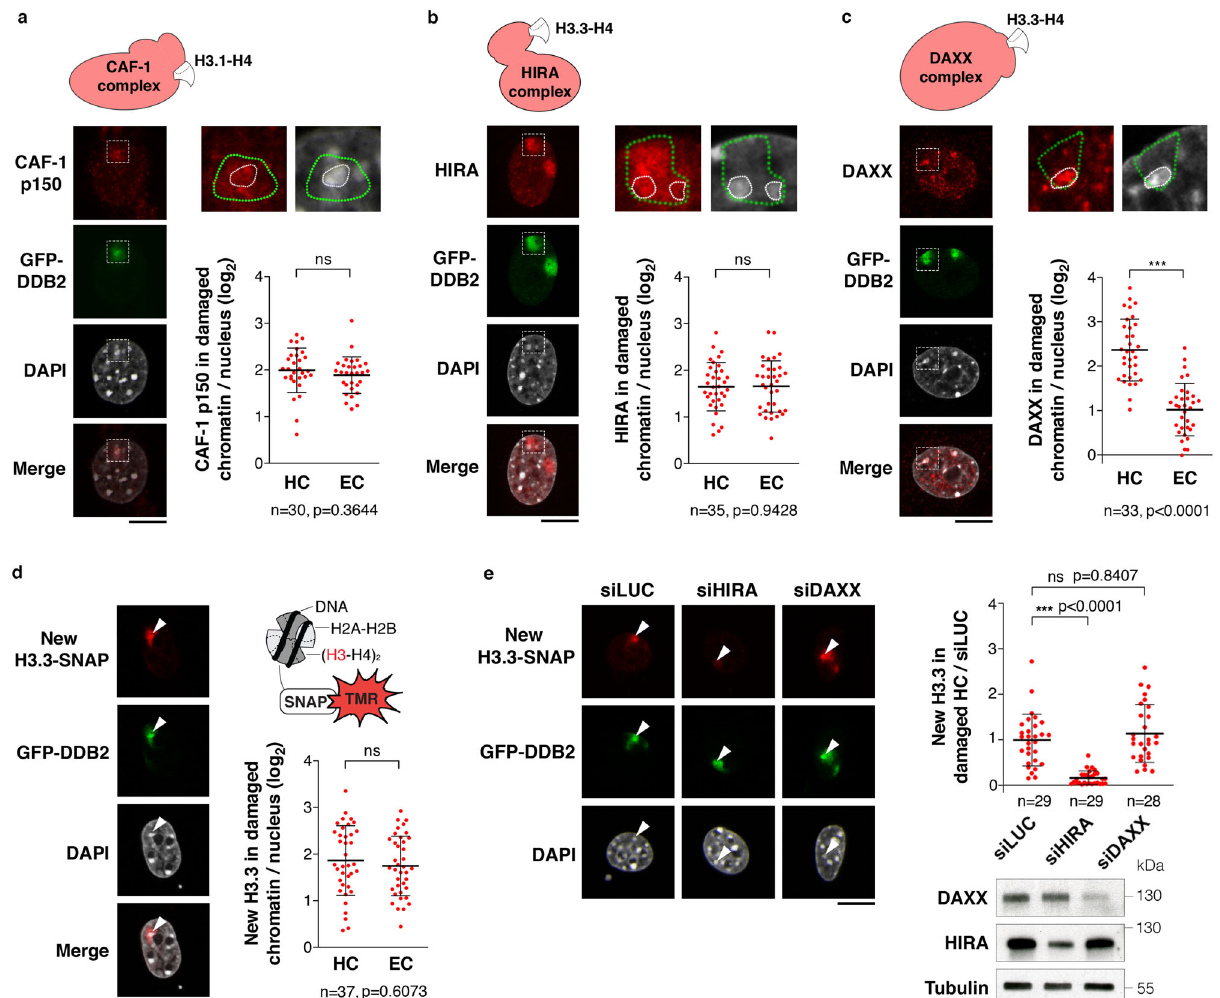
Fig. 5 Histone H3 deposition in UVC-damaged heterochromatin. Recruitment of the H3.1 histone chaperone CAF-1 (p150 subunit) ( a ), and of the H3.3 histone chaperones HIRA ( b ) and DAXX ( c ) to UVC-damaged regions, analyzed by immuno fl uorescence in NIH/3T3 GFP-DDB2 cells 1h30 after local UVC irradiation through micropore fi lters. Zoomed in views (×2.6) show damaged regions (delineated by green dotted lines) containing heterochromatin domains (delineated by white dotted lines). d , e Accumulation of newly synthesized H3.3 histones in UVC-damaged heterochromatin regions (white arrowheads) analyzed in NIH/3T3 GFP-DDB2 H3.3-SNAP cells 45 min after local UVC irradiation through micropore fi lters. H3.3 chaperones are knocked down by siRNA (siLUC, control) ( e ). siRNA ef fi ciencies are controlled by western blot (Tubulin, loading control). Scatter plots represent log2 fold enrichments of histone chaperones or new H3.3-SNAP histones in damaged heterochromatin (HC) and damaged euchromatin (EC) compared to the whole nucleus ( a – d ) or normalized to the corresponding siLUC experiment ( e ). Data are presented as mean values ± SD from n cells scored in at least three independent experiments. Statistical signi fi cance is calculated via two-sided Student ’ s t test with Welch ’ s correction when necessary ( a – d ). Multiple comparisons in ( e ) are performed by one-way ANOVA with Bonferroni post-test. All microscopy images are confocal sections. Scale bars, 10 μ m. Source data are provided as a Source Data fi